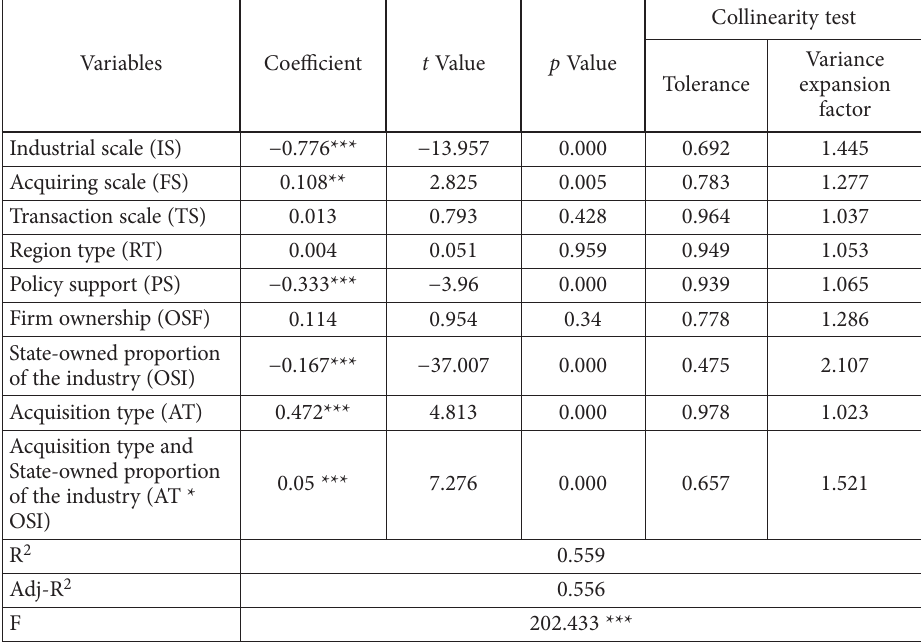
Table 5. The moderating effect of industrial state-owned